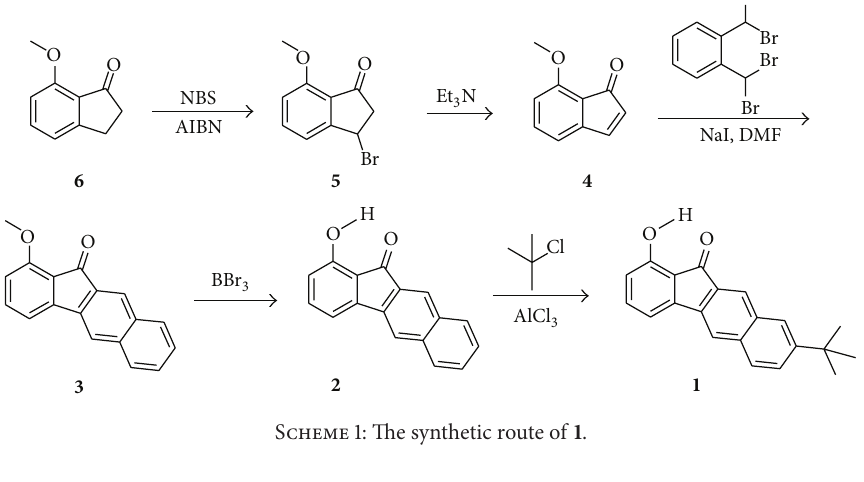
Scheme 1: The synthetic route of 1 .